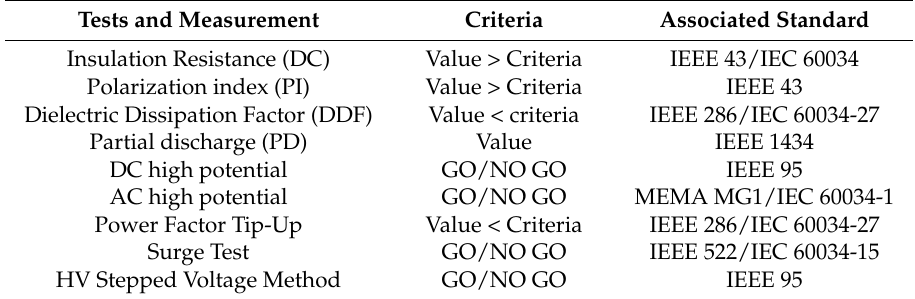
Table 4. List of tests or measurements that can be done in acceptance process of an electrical machine concerning the insulation